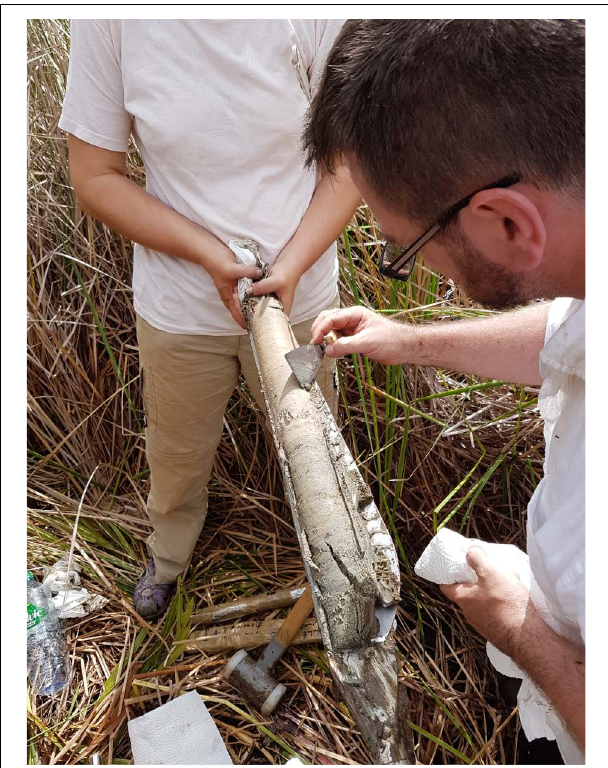
FIGURE 4 | Sediment core extracted from a freshwater marsh located near Belle Mare in 2016. Core analyzed by Dr. Alex Brown, Wessex Archeology based geoarcheologist, as part of initial research undertaken in partnership with Reading University. The core comprises an herbaceous peat (0–0.2 m), dark gray-brown detrital organic lake muds (0.2–0.57 m) overlying olive green silts (0.57 m +). Pollen was poorly preserved, although upper samples of the sequence did include aquatic pollen of Potamogeton , fern spores, along with variable quantities of microscopic